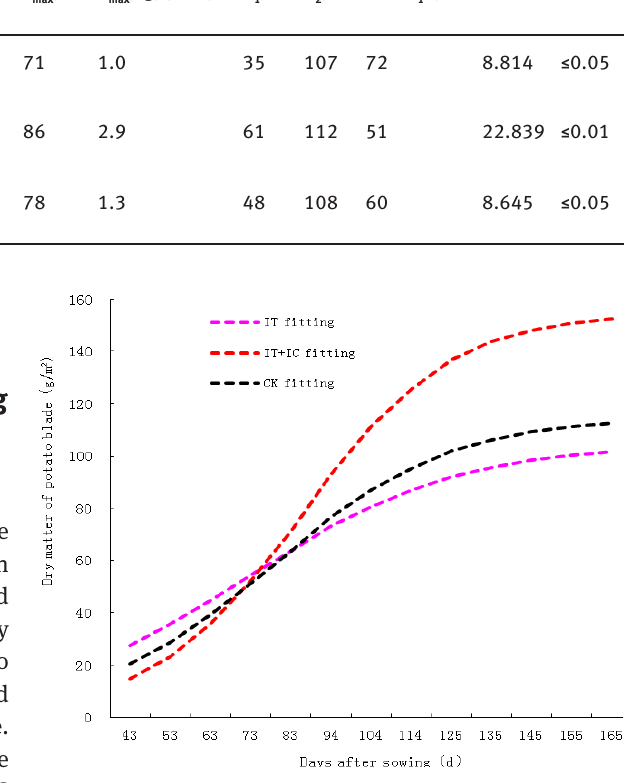
Table 1: Dynamic simulation and characteristic parameters of dry matter accumulation for potato leaf in different treatments. Treatment Dry matter